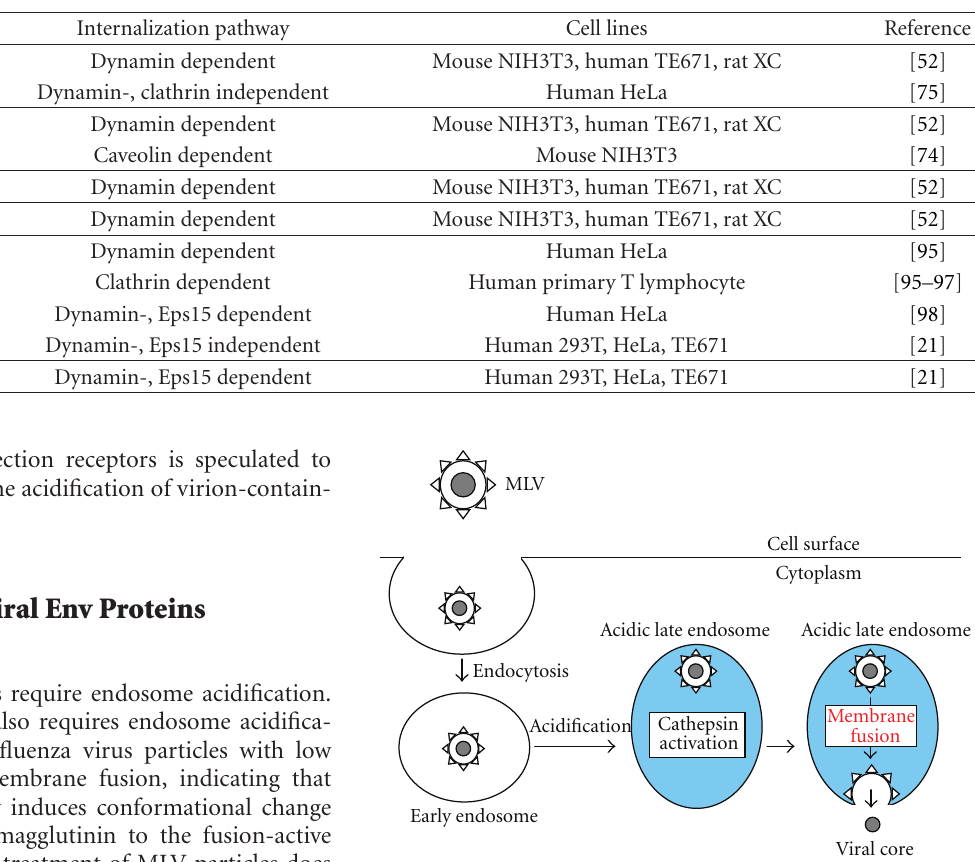
Table 3: Di ff erential internalization pathways of HIV and MLV infections.